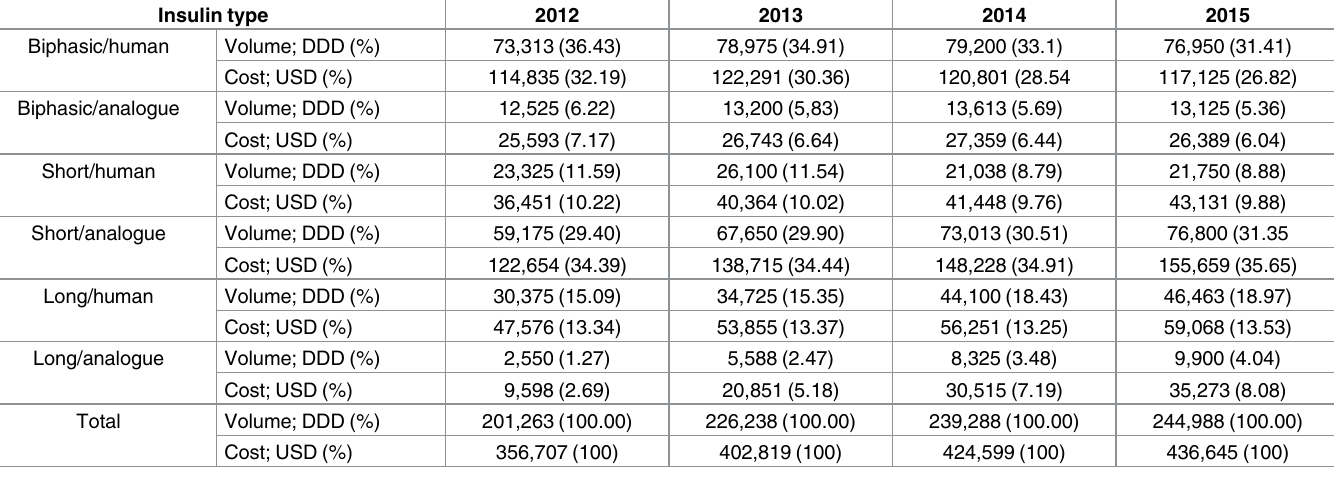
Table 3. Volume and cost of insulins by class-duration of action and molecular origin in Poland. Number of DDDs in thousands. Costs in USD x 1000. Insulin